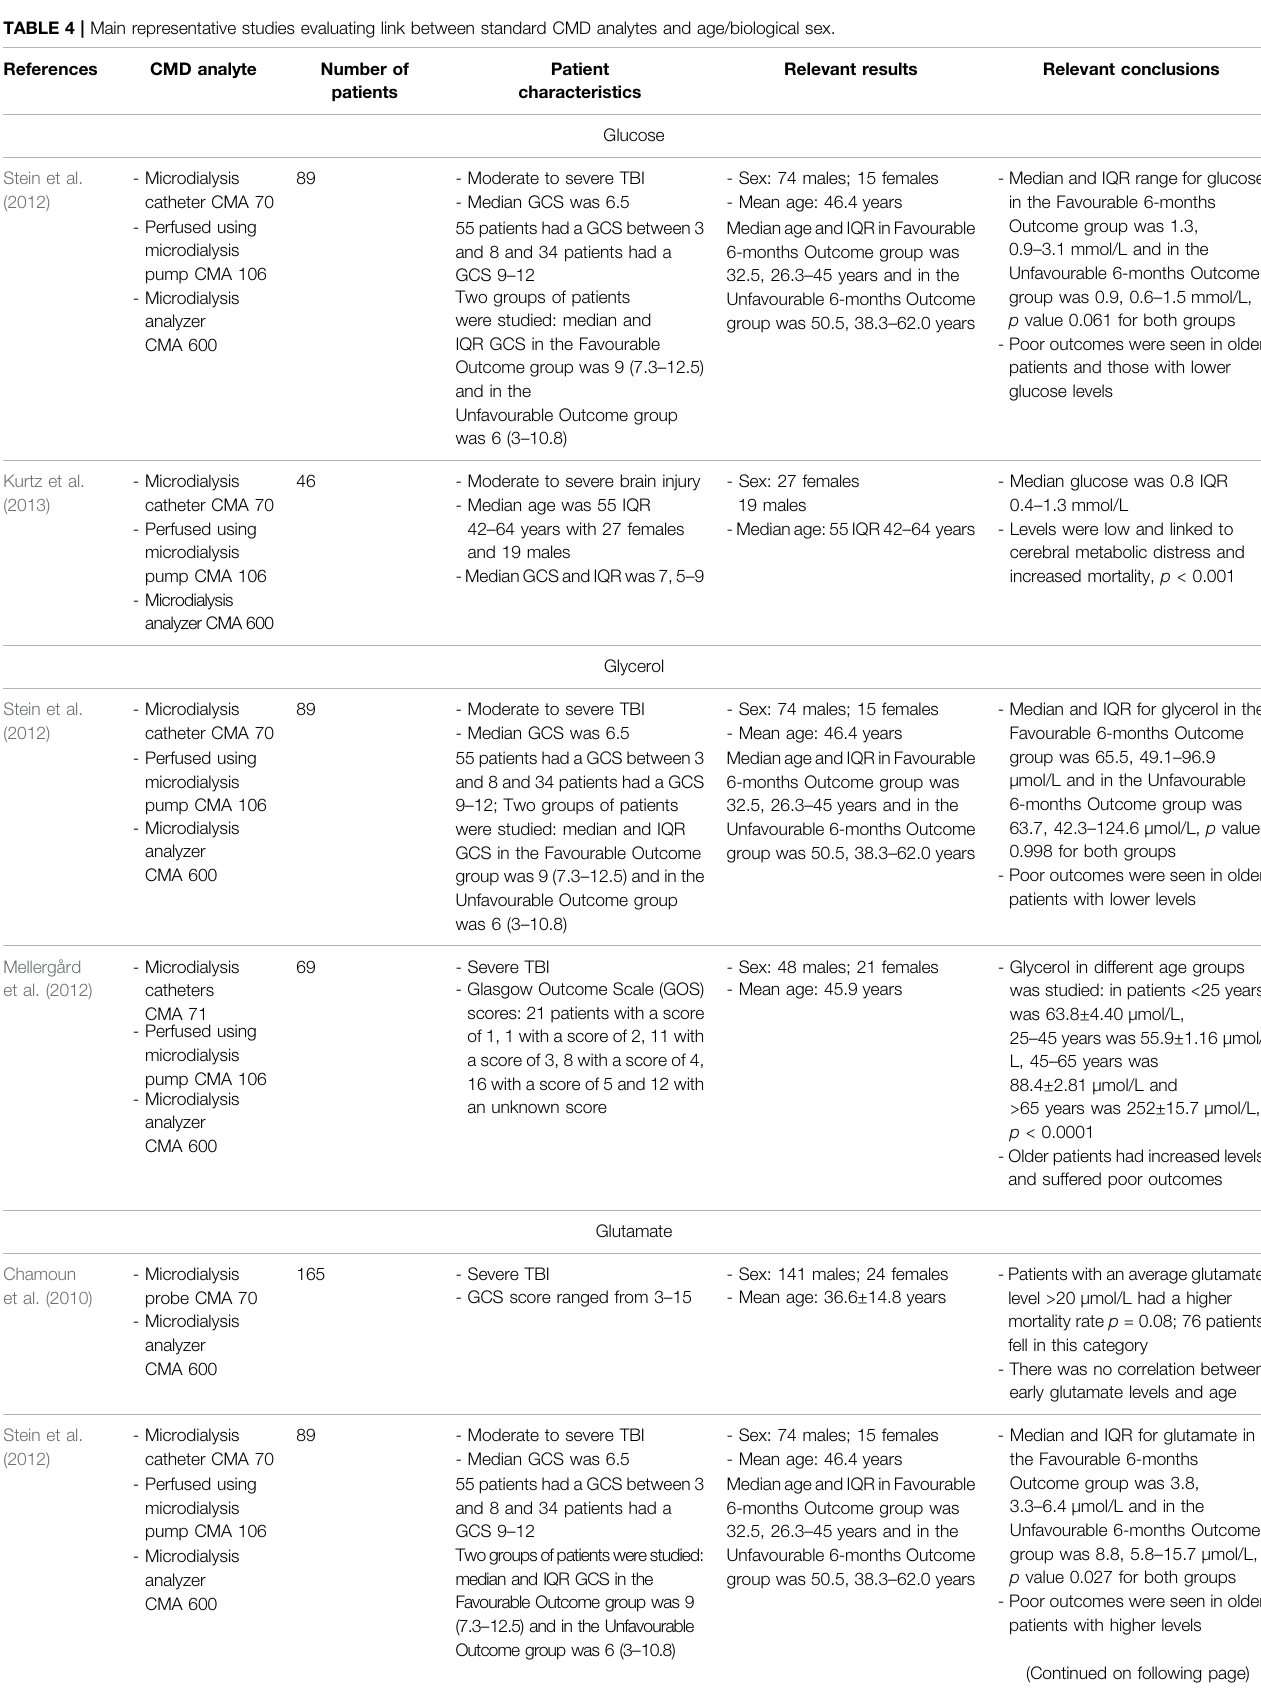
TABLE 4 | Main representative studies evaluating link between standard CMD analytes and age/biological